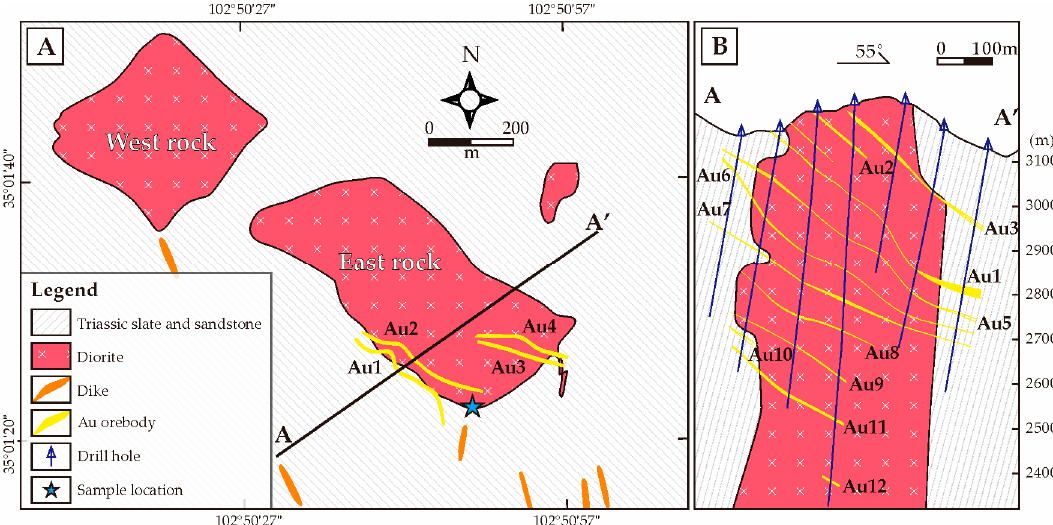
Figure 2. ( A ) Sketch geologic map of the Zaorendao gold deposit and ( B ) selected exploration cross section showing the occurrence of gold ores (after [51]).